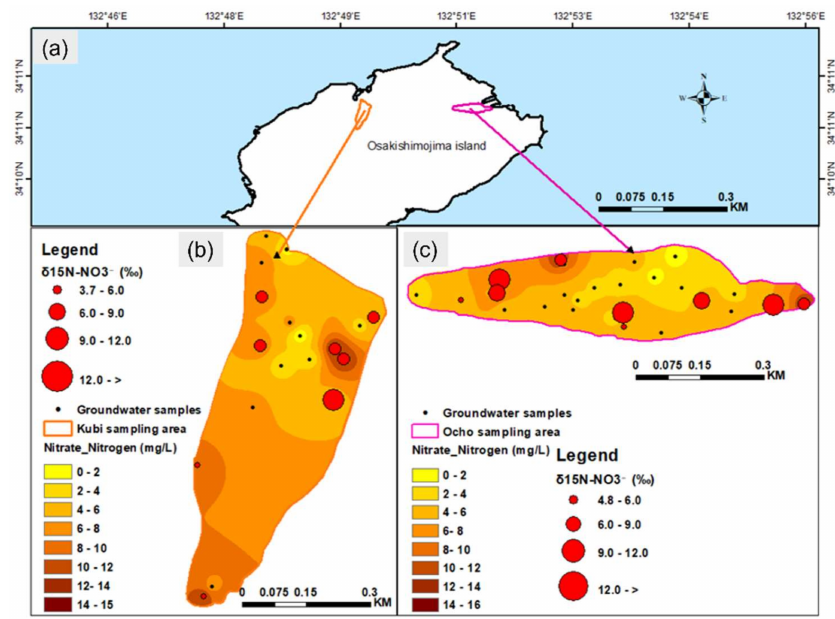
Figure 4. ( a ) Osakishimojima Island, Spatial variation of NO 3 − − N and δ 15 N-NO 3 − concentrations in groundwater of ( b ) Kubi and ( c ) Ocho villages.